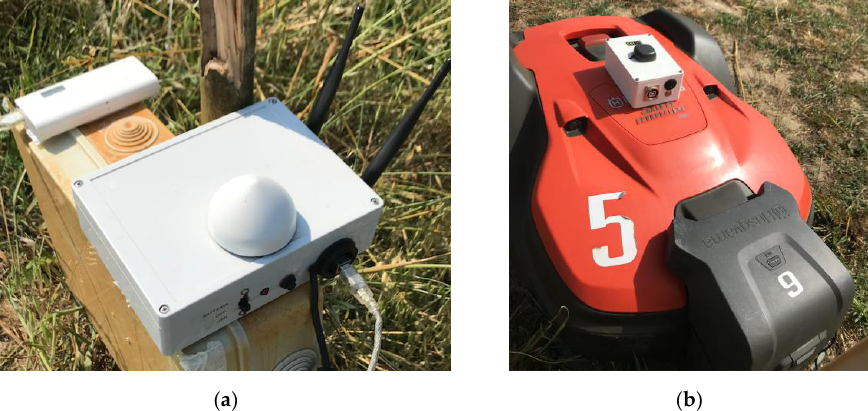
Figure 3. The Emlid Reach RTK devices: ( a ) the base station and ( b ) the rover installed on the autonomous mower AM2.